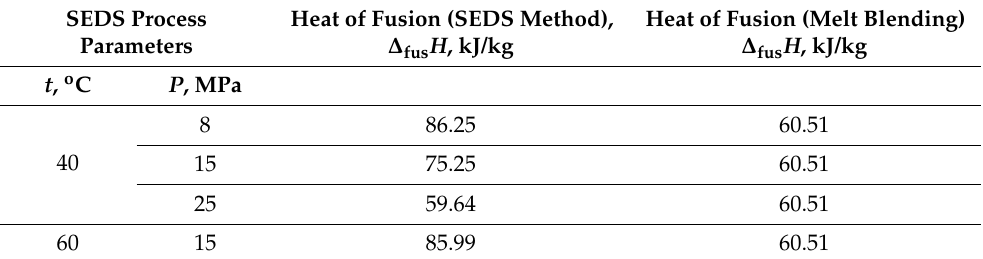
Figure 17. Heat of fusion as a function of concentration of the PP–EPTSR polymer blends, ○ — ob- tained by melt blending (conventional method); ●— produced by SEDS method (at t = 40 °C and P = 8 MPa). Table 5. Influence of operating conditions of the process of dispersion (PP 75%+ EPTSR 25%) polymer blend by the SEDS method on the heat of